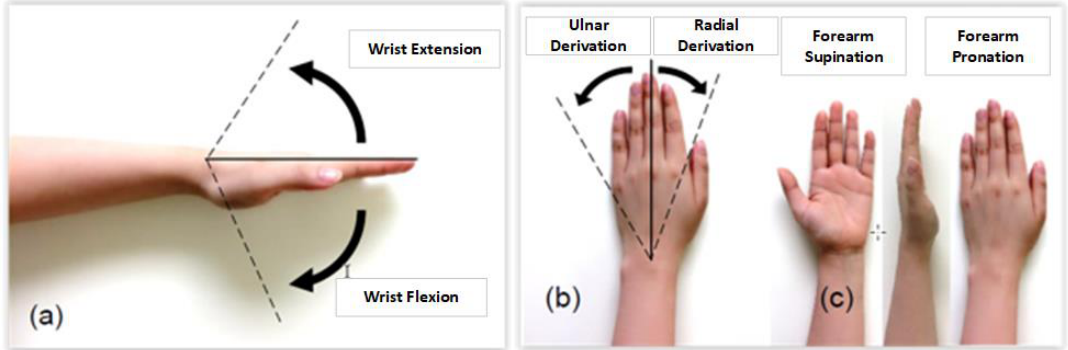
Figure 1. Movable RoM of the hand. ( a ) Wrist joint: extension and flexion, ( b ) Wrist joint: radial and ulnar deviation, ( c ) Forearm movement: supination and pronation.